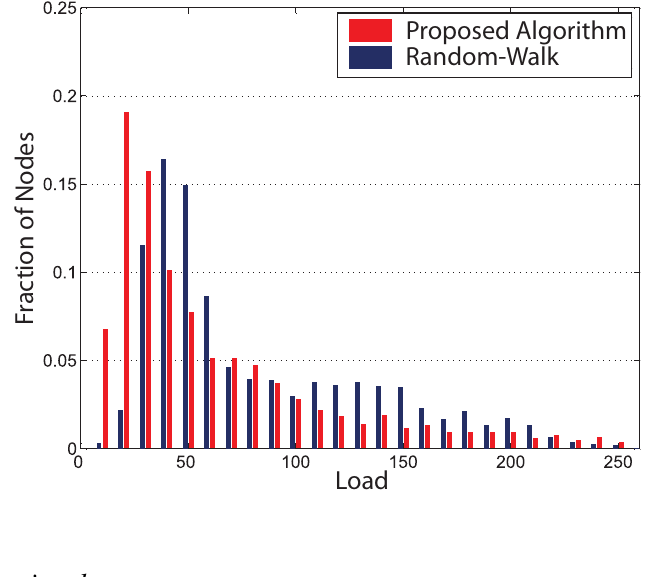
Figure 11. Load distribution in routing.